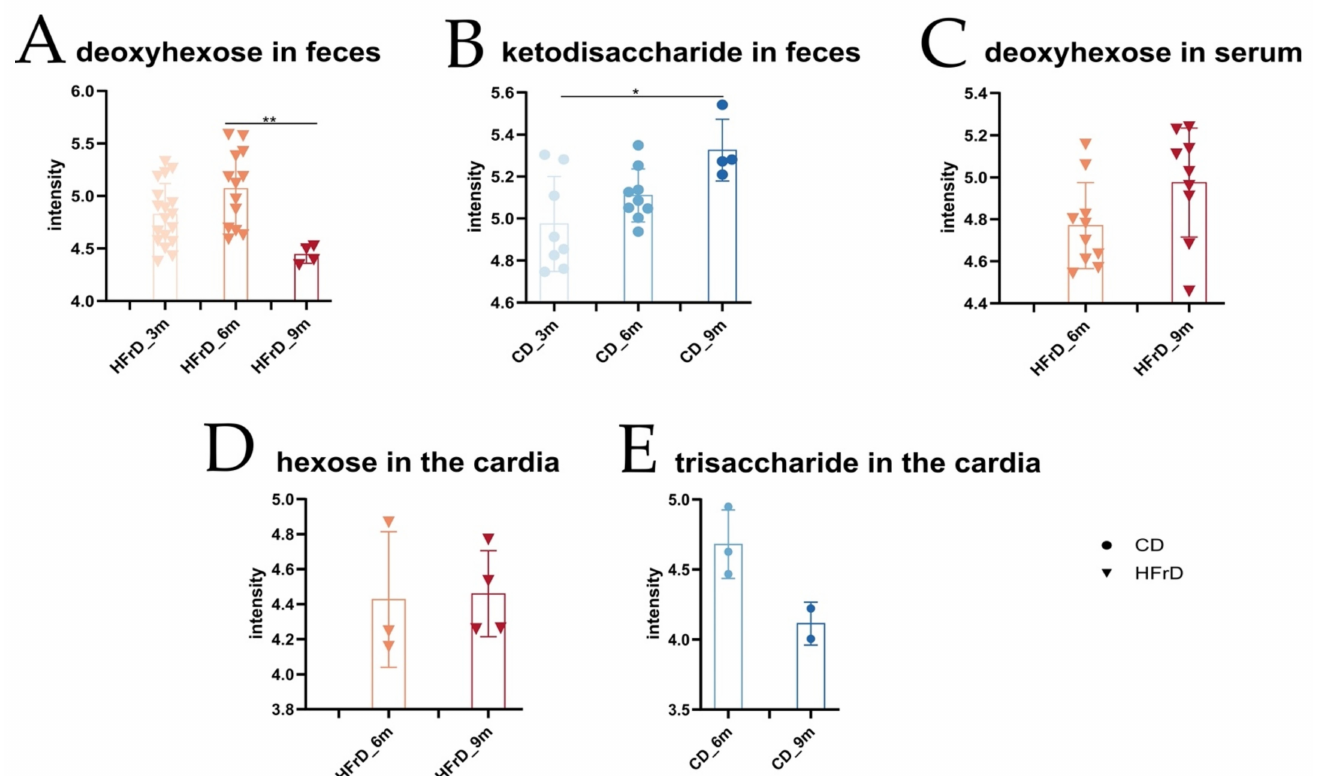
Figure 3. Untargeted metabolomic profiles in feces, serum, and cardia tissue. Considered metabolites were found in either the CD-fed or the HFrD-fed mice. ( A ) Deoxyhexose in fecal samples of HFrD-fed mice. Content of deoxyhexose decreased significantly between samples of 6-month-old and 9-month-old mice ( p = 0.0032); ( B ) ketodisaccharide in fecal samples of CD-fed mice. Content of ketodisaccharide increased significantly between samples of 3-month-old and 9-month-old mice ( p = 0.0110); ( C ) deoxyhexose in serum samples of HFrD-fed mice. Content of deoxyhexose did not differ significantly between the age groups; ( D ) hexose in cardia tissue of HFrD-fed mice. Content of these monosaccharides did not differ significantly between the age groups; ( E ) trisaccharide in cardia tissue of CD-fed mice. Content of trisaccharide did not differ significantly between the age groups; statistical comparison between the age cohorts. Data are represented as mean ± SD. ( A , B ): Depending on the normal distribution of the data, either an ordinary 1-way ANOVA with Tukey’s multiple comparisons test or a Kruskal–Wallis Dunn’s multiple comparisons test was performed for the statistical analysis. ( C – E ): Depending on the normal distribution of the data, either an unpaired t -test or a Mann–Whitney test was used for the statistical analysis. ( A – E ): circles represent samples from CD-fed mice and triangles represent samples from HFrD-fed mice. Increasing blue shades correspond to CD-fed mice (3m to 9m) and increasing red shades correspond to HFrD-fed mice (3m to 9m). Significance level: * (significant); ** (very